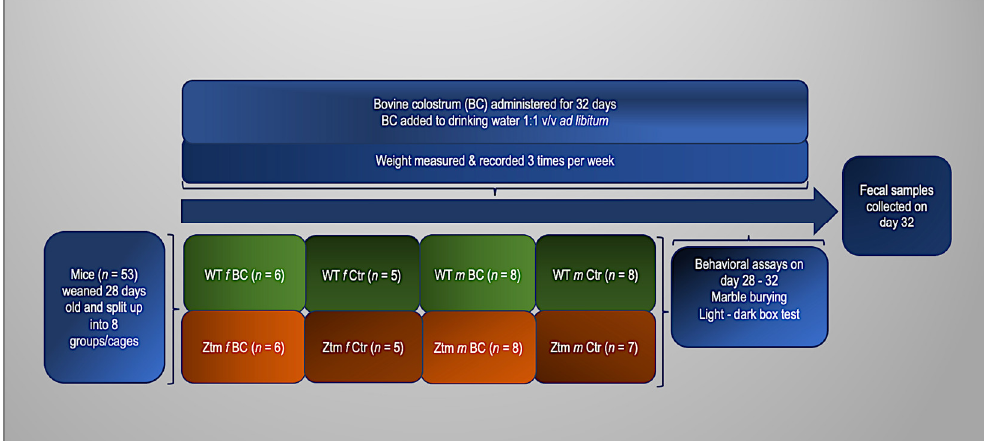
Figure 1. Experimental timeline and flowchart. WT and Ztm mice in separate cages, females and males, receiving either BC added to drinking water (1:1 v / v ) or water only ad libitum for 32 days. Behavioral assays performed on day 28–32 and fecal samples collected on day 32. BC = bovine colostrum treatment; WT = wild-type mice; Ztm = zonulin transgenic mice; Ctr = control mice, f = female; m = male; v / v = volume per volume, ad libidum = as much or as often as necessary or desired; n = number of mice in each group.